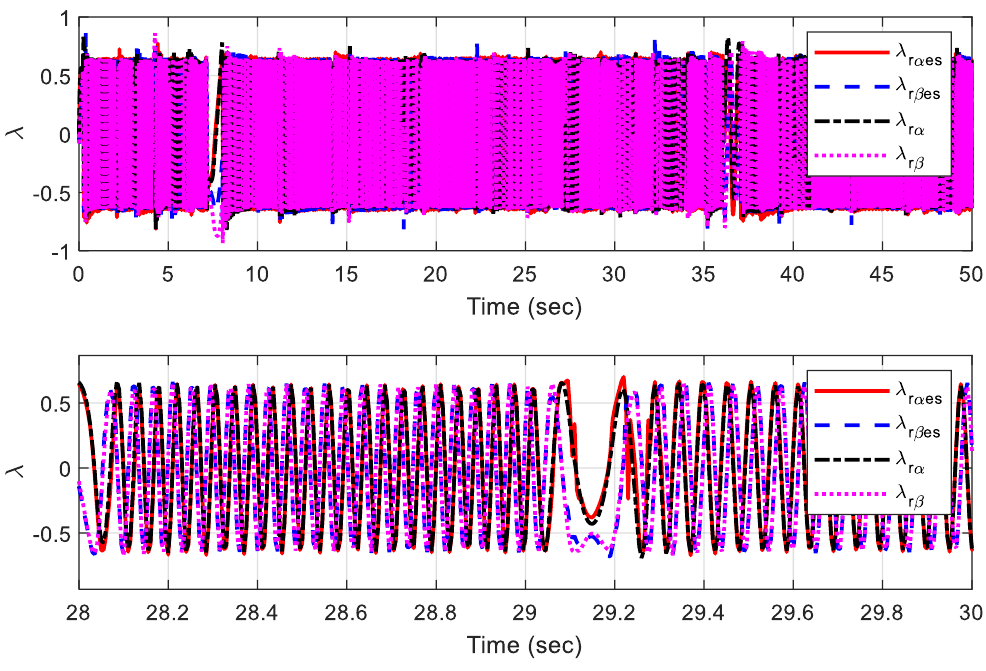
Figure 18. Dynamic performance of actual and estimated fluxes.